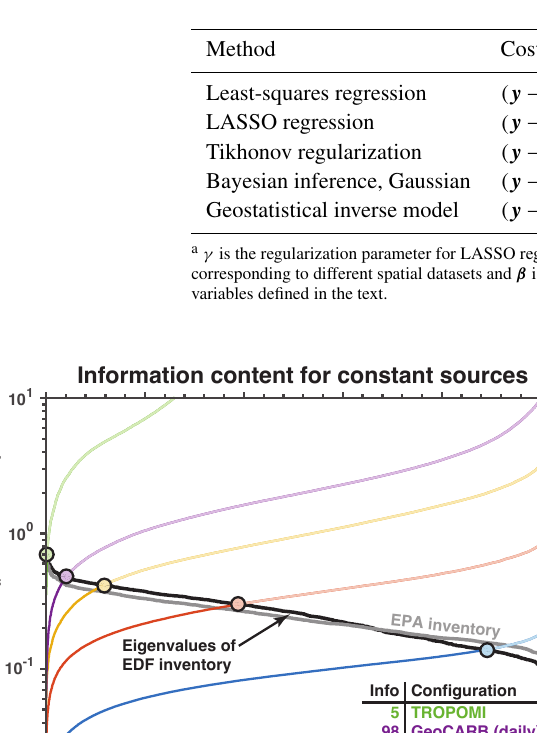
Table 2. Cost functions for different formulations of the inverse problem a .